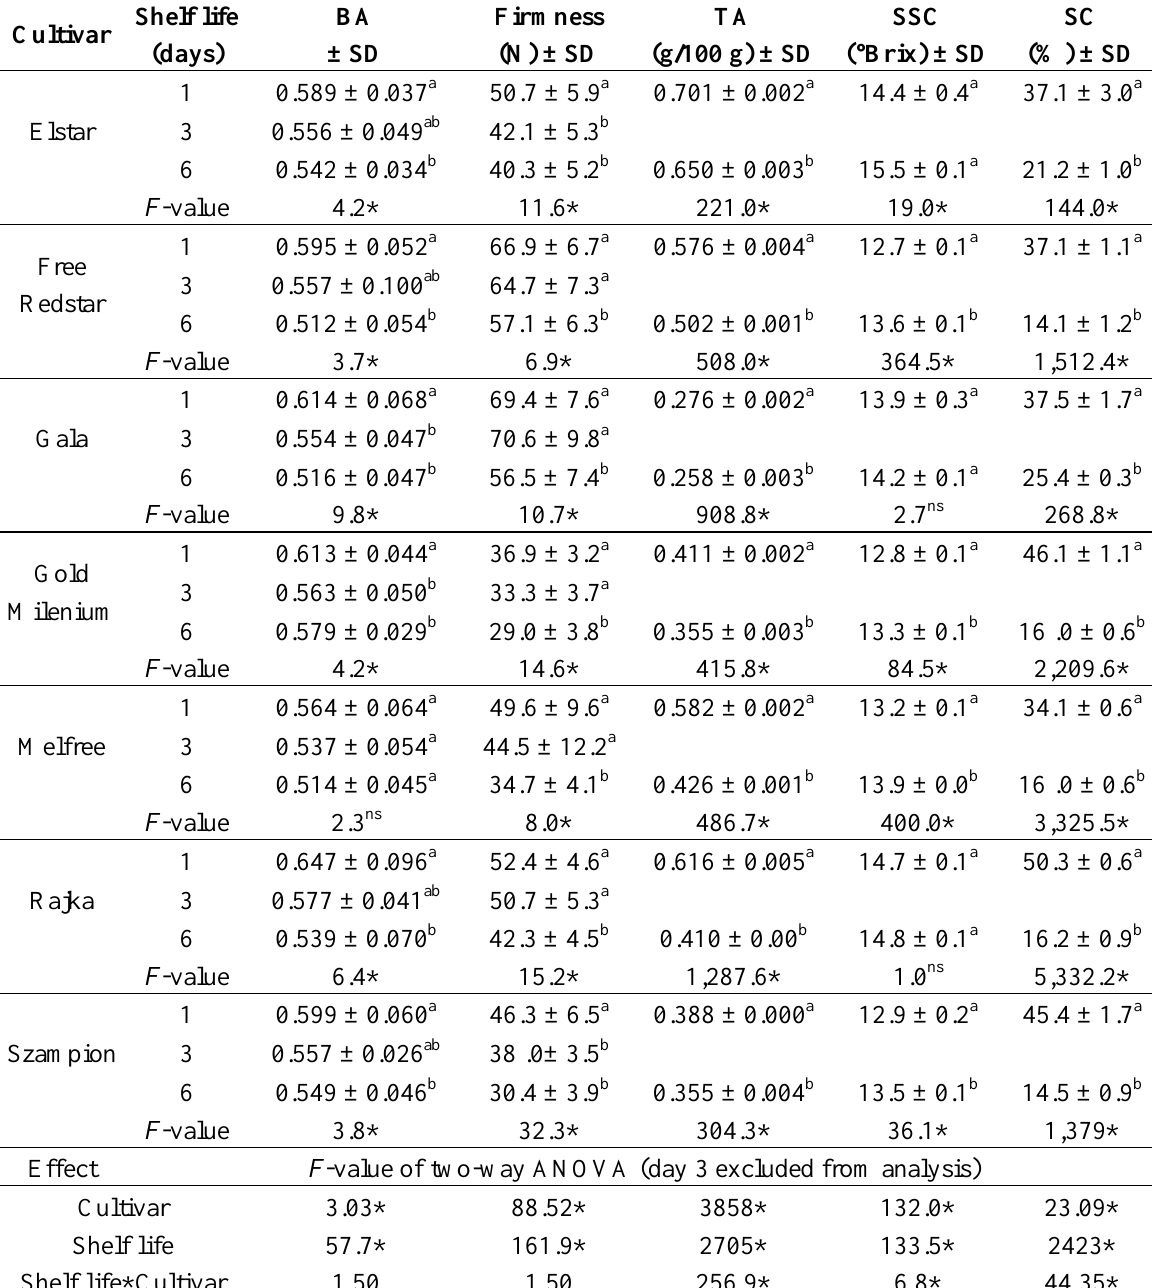
Table 1. Quality attributes and biospeckle activity of apples during shelf life. SD—standard deviation, BA—biospeckle activity, TA—titratable acids, SSC—soluble solids content, SC—starch